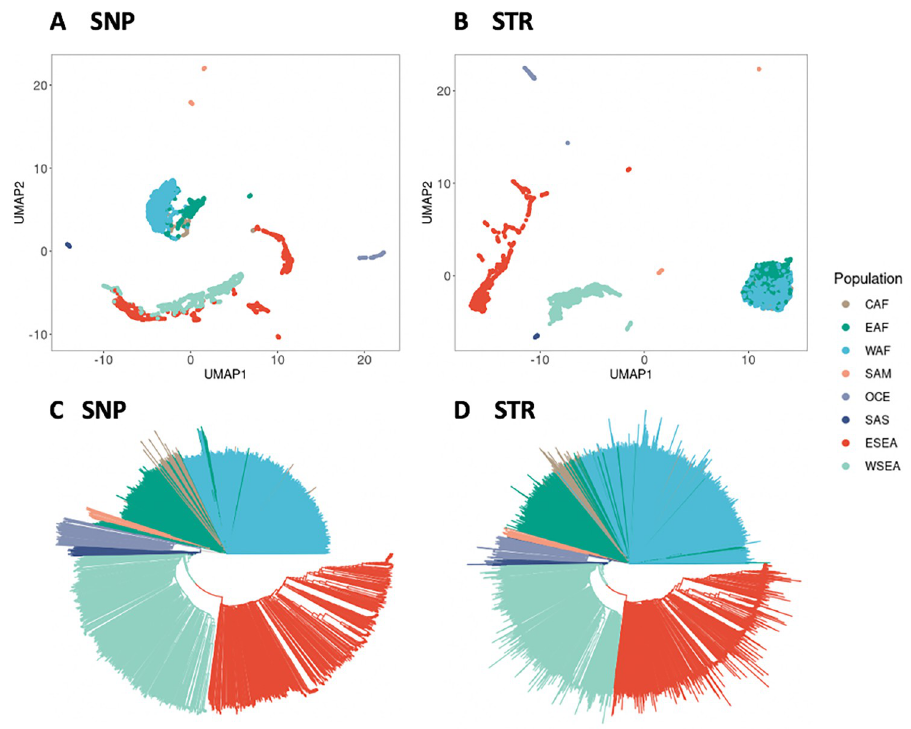
Fig 3. Population structure analysis of the 3,047 P . falciparum samples of SNP and STR data. (A) UMAP clustering of the top five principal components of the SNP data, colours representing the eight different populations. (B) UMAP clustering of the top five principal components of the STR data. (C) Neighbor joining tree based on the SNP data. (D) Neighbor joining tree based on the STR data. Branches are colored according to the population.